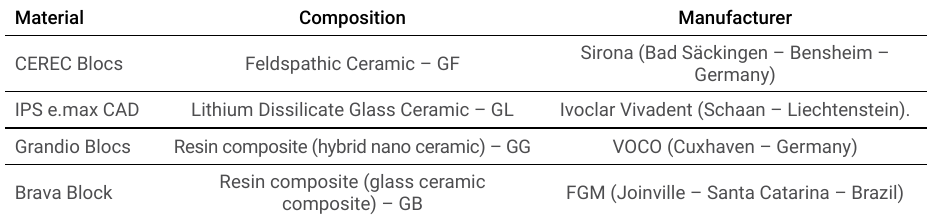
Table 1. Type, composition, and manufacturer of the four tested materials Material CEREC